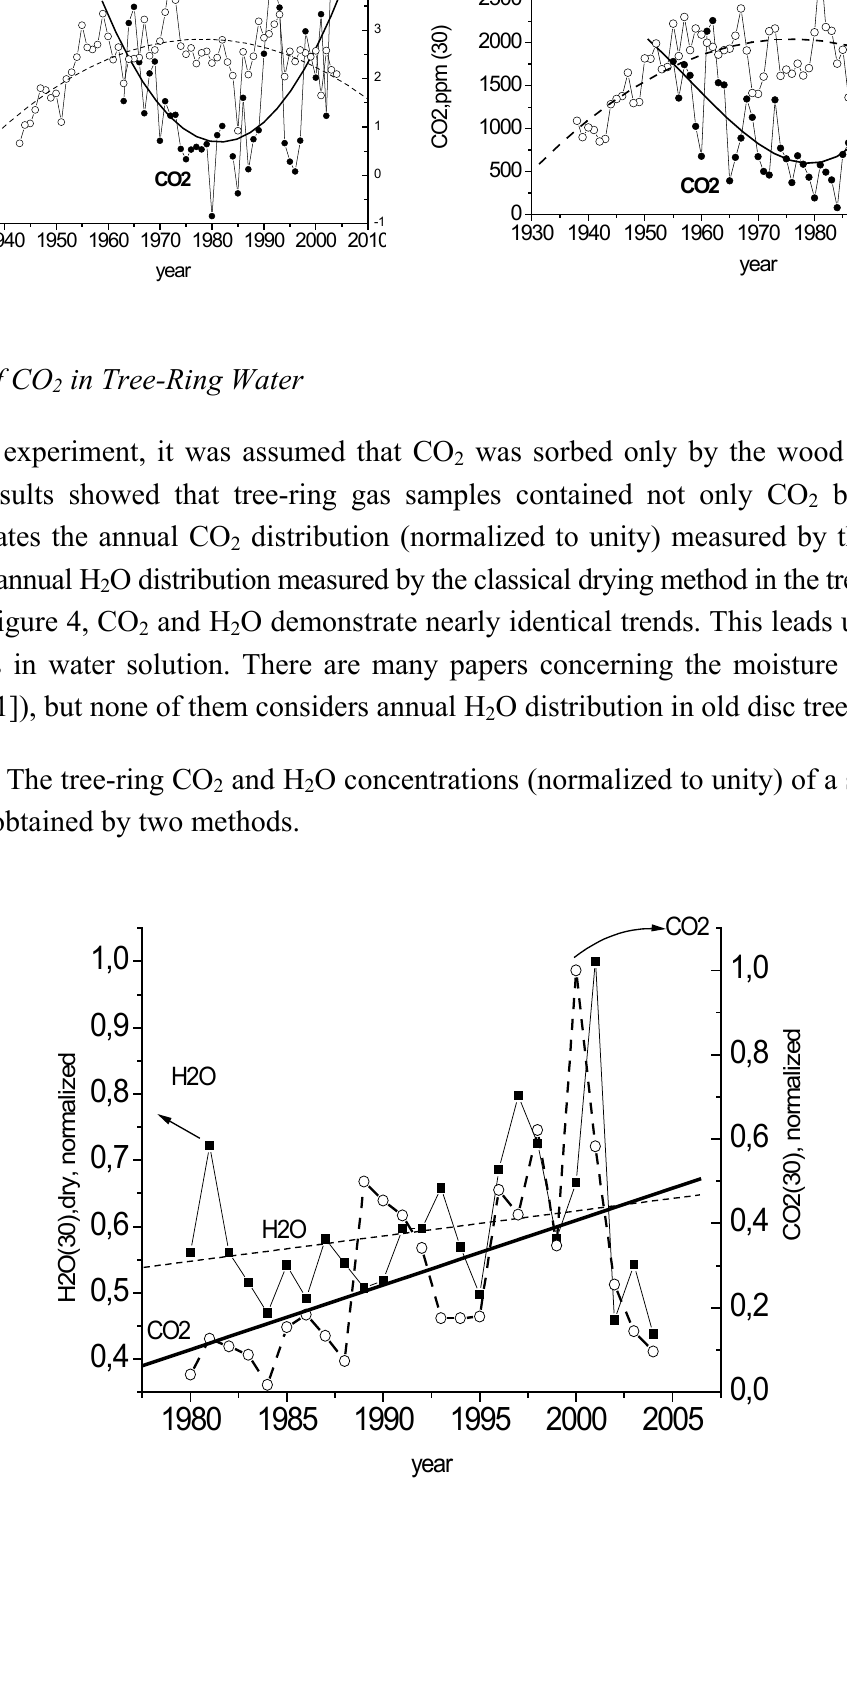
concentration and widths of spruce discs 2